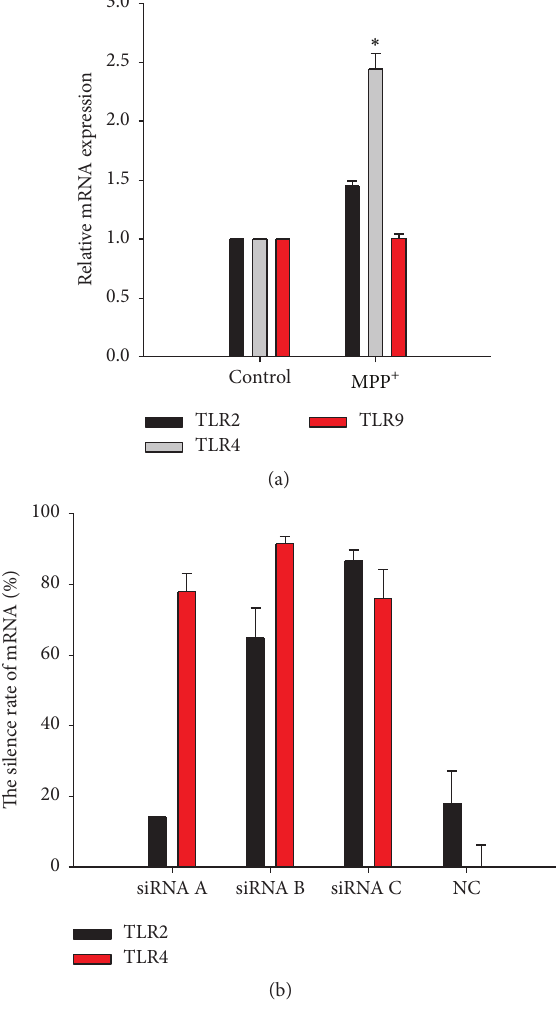
Figure 5: (a) The mRNA levels of TLR2, TLR4, and TLR9 in the BV-2 cells exposed to MPP + for 12h. Note that there was a statistical increase in TLR4 mRNA after 0.1mM MPP + incubation for 12 hours compared to control group ( ∗ 𝑃 < 0.05 ). No significant differences in TLR2 mRNA and TLR9 mRNA levels were found between 0.1mM MPP + group and the control. (b) Relative silencing efficiency of TLR2 RNAi and TLR4 RNAi in the BV-2 cells. The mRNA was measured after the cells were incubated with 0.1 mM MPP + . Note that the silencing efficiency was over 70% in the group of TLR2 siRNA C and over 90% in that of TLR4 siRNA B.